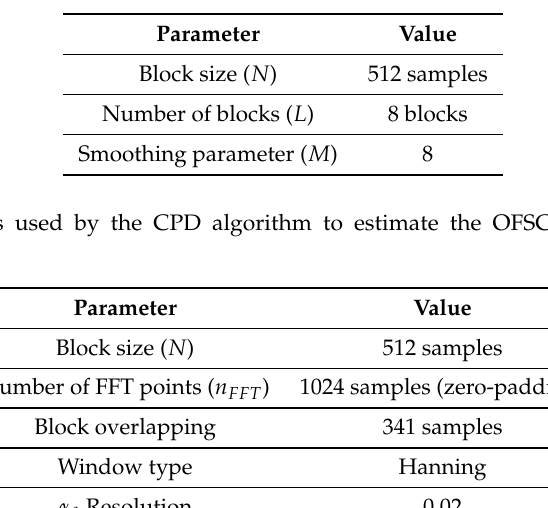
Table 1. Parameters used by the CPD algorithm to estimate the SCD function.